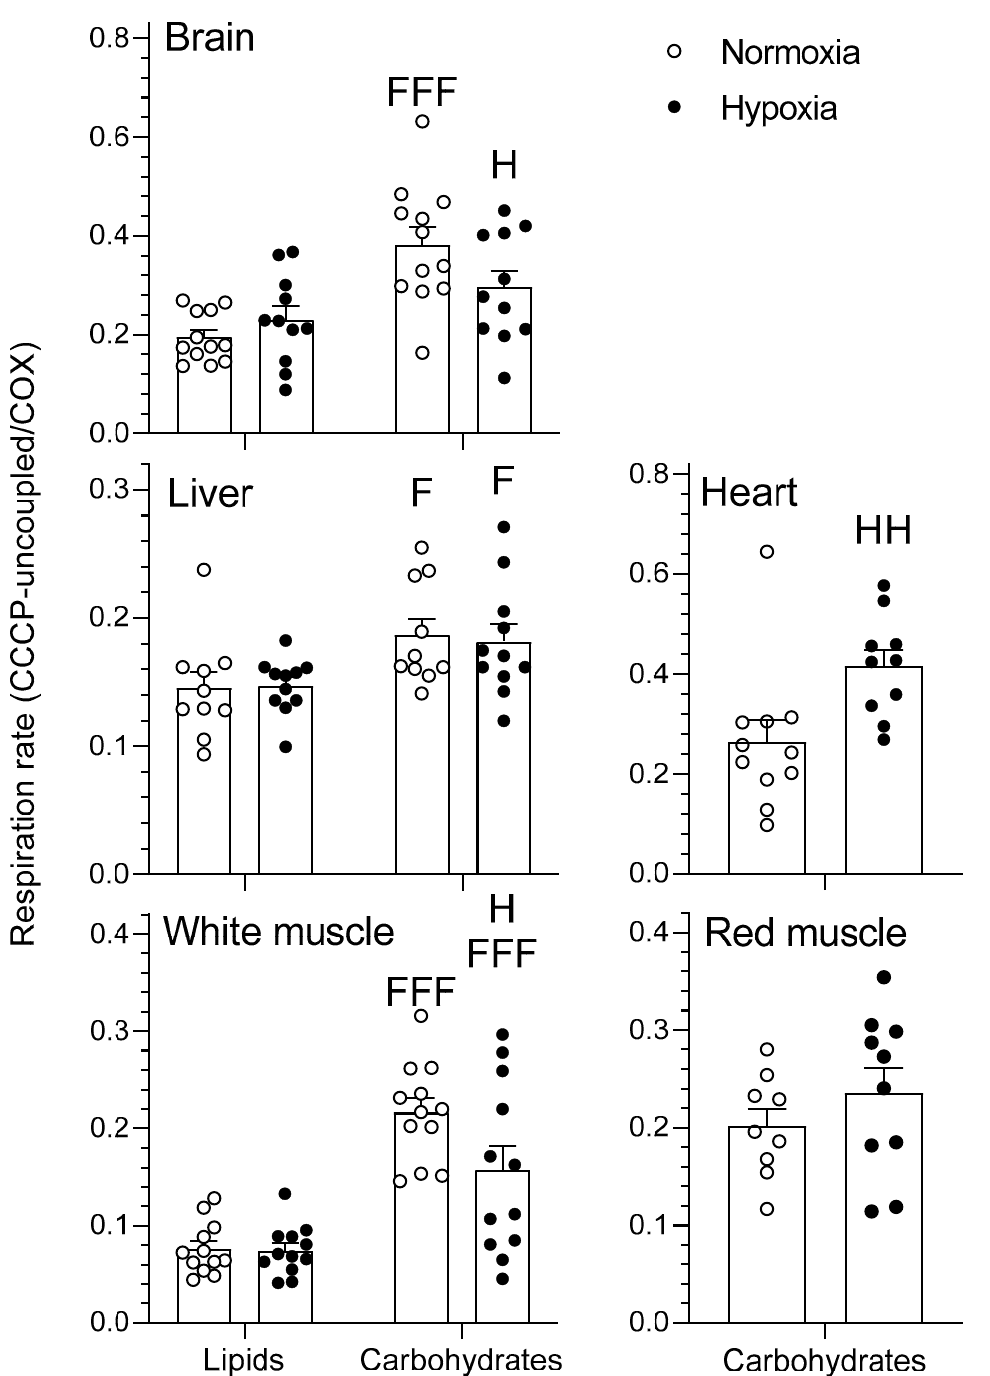
Figure 4. Mitochondrial oxidative fuel preference during the CCCP-uncoupled state (pmol O 2 sec − 1 mg –1 ) normalized to COX respiration in the tissues of normoxic controls ( N = 12) and hypoxia-acclimated goldfish ( N = 11). The CCCP-uncoupled state represents mitochondrial respiration following titration of carbonyl cyanide m-chlorophenyl hydrazone (CCCP) in the presence of pyruvate/malate + ADP + glutamate + succinate + cytochrome C for the carbohydrate protocol and palmitoylcarnitine/malate + ADP + cytochrome C for the lipid protocol. Values are means ± s.e.m. Dots represent individual data points. Differences between fuels are indicated as F ( p < 0.05) and FFF ( p < 0.001). Differences between oxygen levels are indicated as H ( p < 0.05) and HH ( p < 0.01).